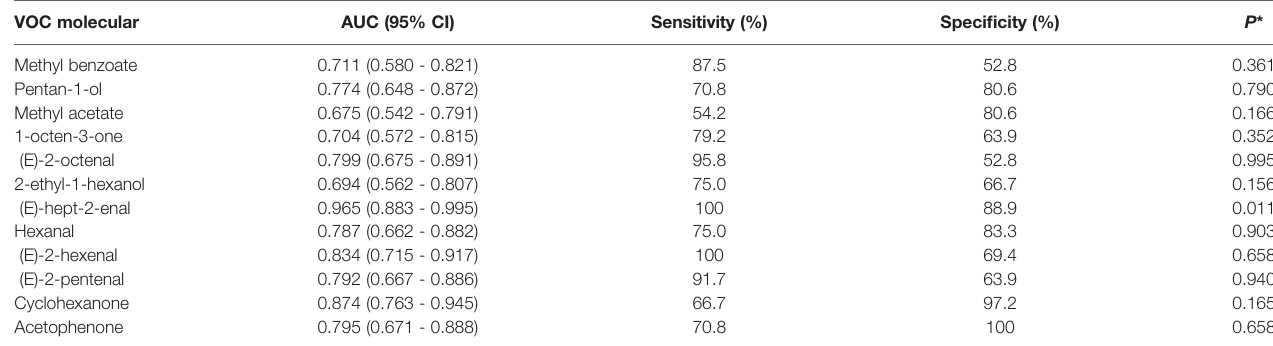
TABLE 2 | The AUC, sensitivity and speci fi city of each VOC for GBC diagnosis. VOC